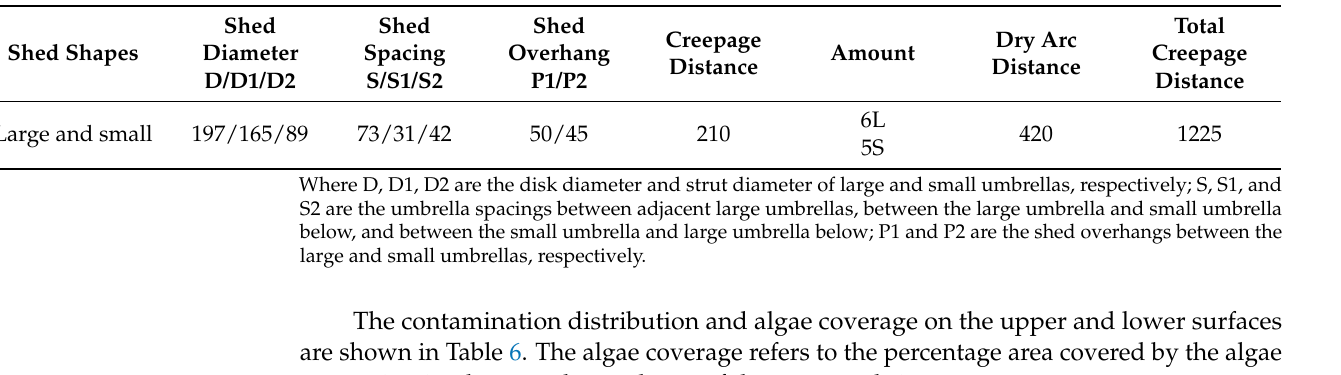
Table 5. The algae shed parameters of the pillar insulators